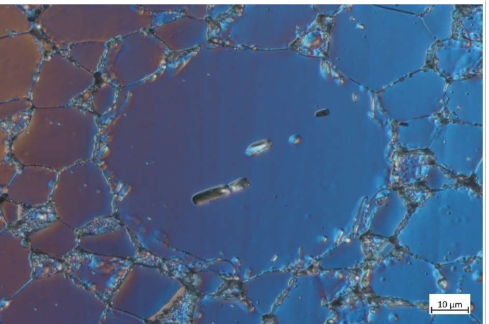
Figure 9. Interparticle porosity of 420 ◦ C/480 s